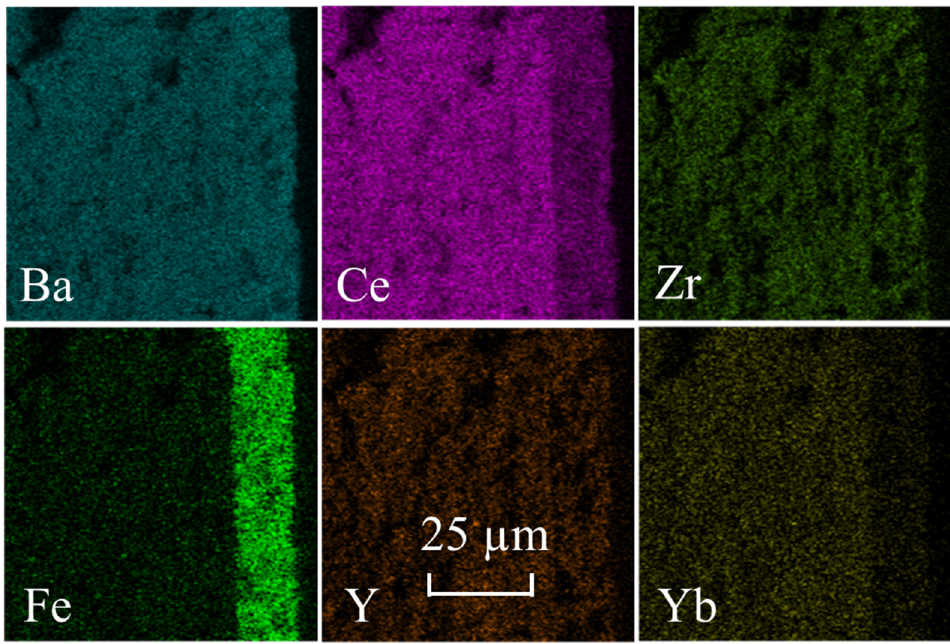
Figure 3. Distribution maps of main elements in the SDC with the BCZYF0.5 non-activated elec- trode.